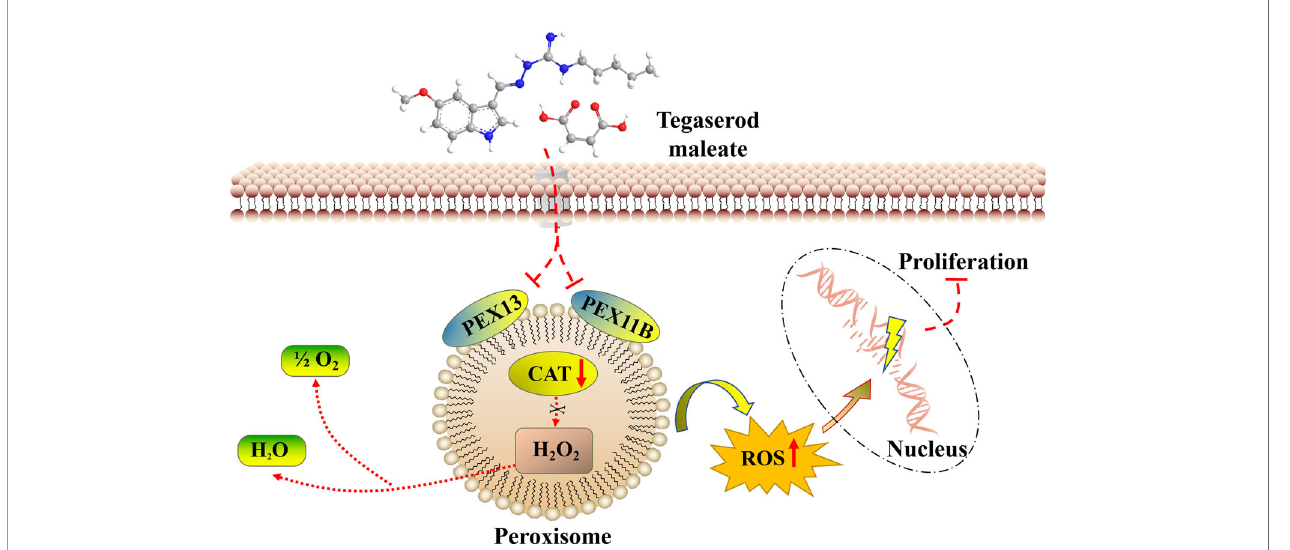
FIGURE 7 | The molecular mechanism diagram of tegaserod maleate inhibition of